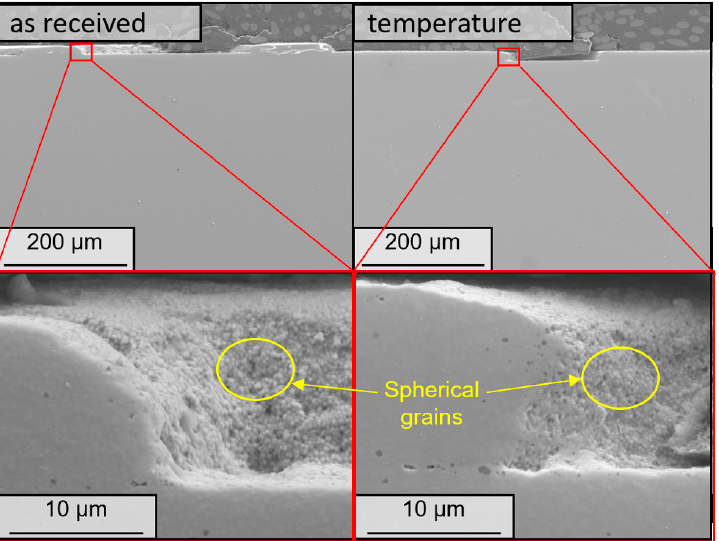
Figure 5. SEM images of the cross section of ZrO 2 samples before molten salt exposure (as received) and after pure heat treatment in hot Ar (temperature).